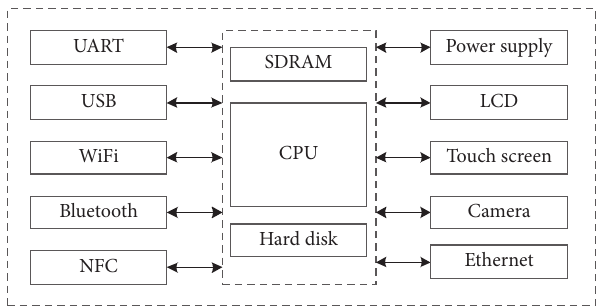
Figure 3: Hardware structure of central